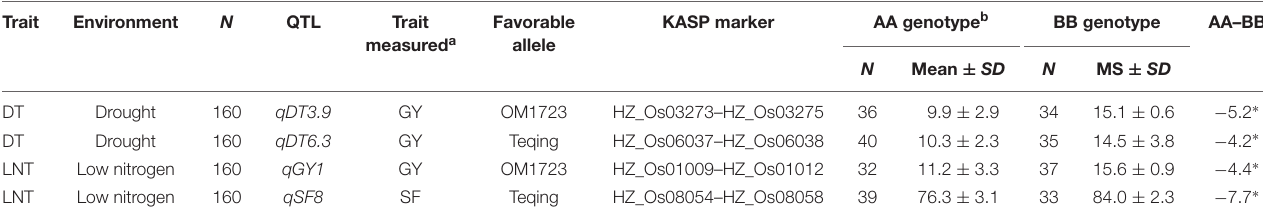
TABLE 4 | Validation of DT- and LNT-QTL in the pyramiding F 2 population derived from M387 × M79 under drought and low nitrogen conditions.